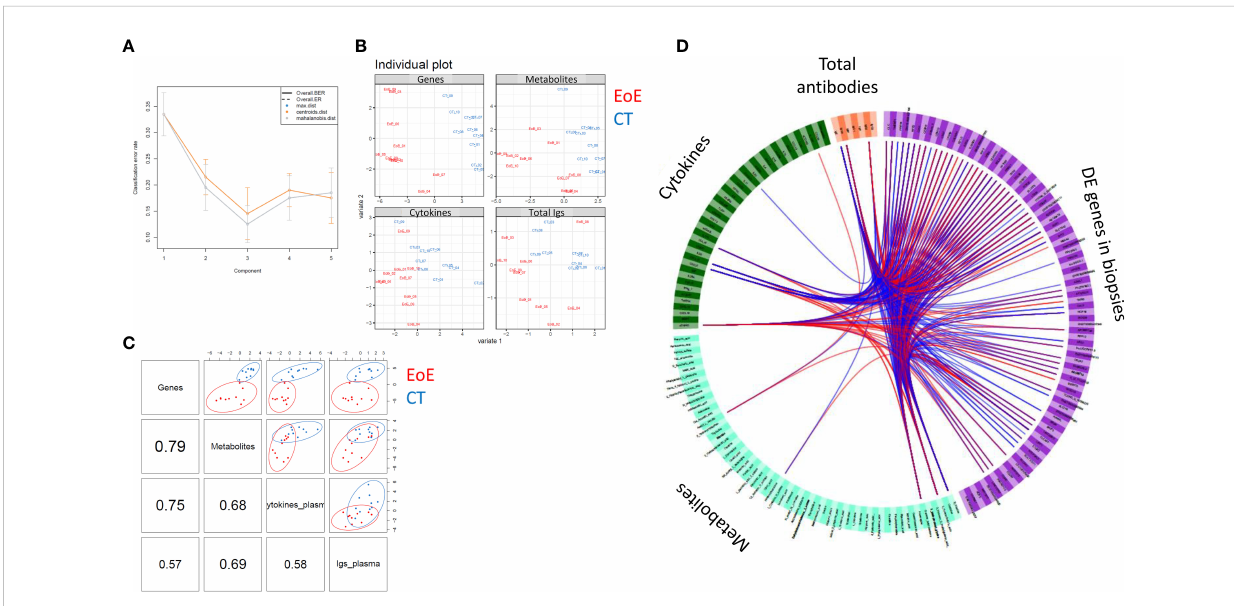
FIGURE 6 Association between circulating cytokine, antibody, and metabolite levels and local EoE transcriptomic signature. To obtain a statistically robust model, 341 genes were selected, corresponding to the highest and most robust DE expressed genes between EoE patients and controls (|FC| > 1.5, p < 0.01; n = 10 per group, corresponding to individuals with a clear transcriptomics EoE signature and no missing data). All cytokines, antibodies, and metabolites (full names in Supplementary Table 4) measured in plasma were considered and all data were scaled before integration. (A) Diagnostic test: a three- component model was selected based on the total error (ER) and balanced error rate (BER). (B) The individual plots for each dataset (transcriptomics, metabolomics, cytokines and antibodies) showed good separation of EoE patients (red) from controls (blue). (C) Pairwise correlations among the different datasets and corresponding distribution of the individuals [same colour code as in (B) ]. (D) Circos plot showing all variables selected by the fi nal DIABLO model for each block. Associations higher than >|0.7| are indicated with blue (negative) or red (positive) lines. Please see Data Sheet 1 for better